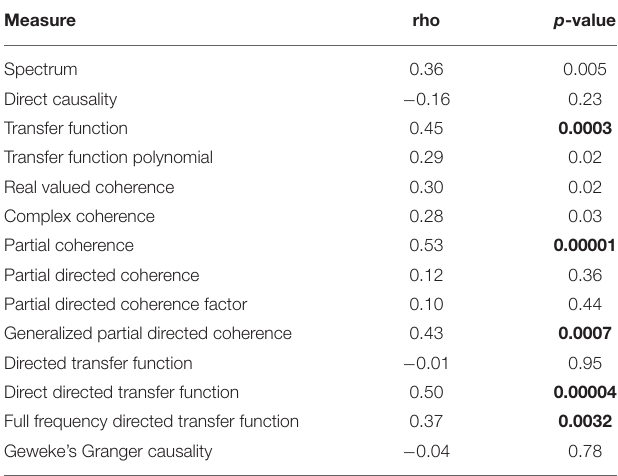
TABLE 2 | Spearman correlation coefficients for the relationship between test-retest reliability based on artifact-free data and included number of artifact-free